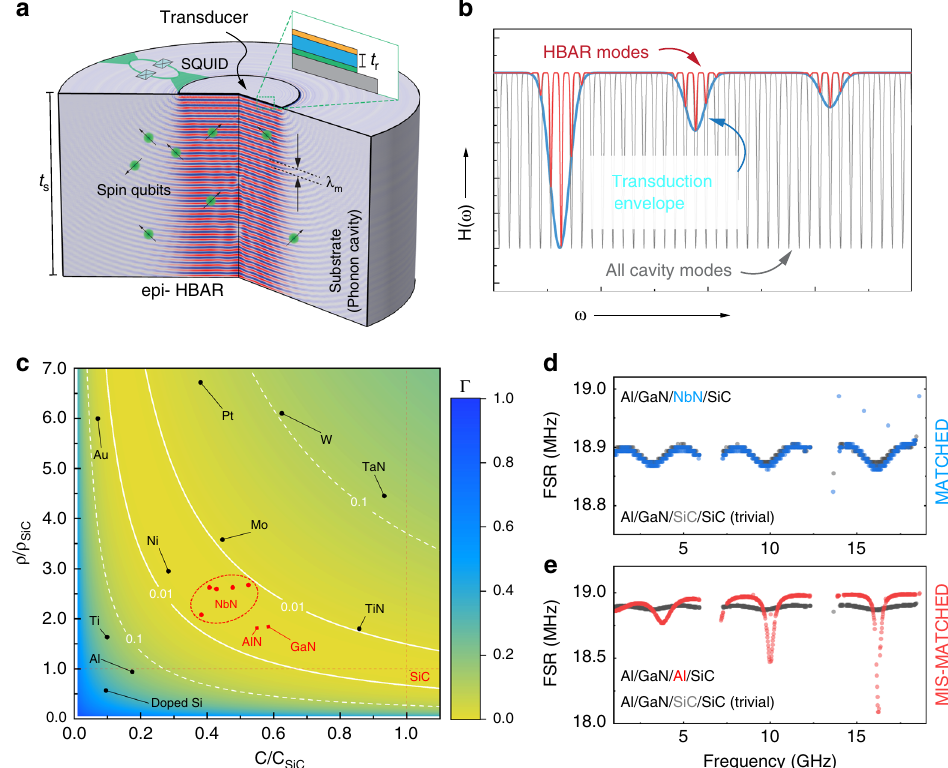
Fig. 1 The epi-HBAR as a versatile and ef fi cient multimode phonon source for quantum acoustodynamic systems. a A depiction of phonon cavity modes of the epi-HBAR generated by the thin epitaxial piezoelectric transducer and con fi ned in the substrate. Phonon – qubit coupling can be possible with planar/ vertical NbN-based superconducting qubits, or with spin qubits in the SiC substrate. b The net spectral response (red) of an epi-HBAR is the superposition of the transduction envelope (blue) of the electrode/piezoelectric/electrode transducer, and the cavity modes (gray) of the substrate. c The parameter space of the Fresnel acoustic power re fl ection Γ as a function of stiffness and mass density of the bottom electrode, normalized to the values for the SiC substrate. All epitaxial materials in the epi-HBAR, especially the critical NbN bottom electrode, are acoustically impedance matched to the substrate (that is the power re fl ection coef fi cient Γ < 0.01), resulting in ef fi cient acoustic power injection (1 − Γ ) into the phonon cavity. Calculated FSR spectra for ( d ) NbN and ( e ) Al bottom electrodes compared with the trivial solution with a SiC bottom electrode (perfectly matched acoustic impedance) demonstrates the difference between impedance matched and mismatched conditions. The FSR distribution for the calculated Al/GaN/NbN/SiC epi-HBAR agrees closely with the experimental data from Fig. 2. Note that ( d ), ( e ) do not have the same Y -axis